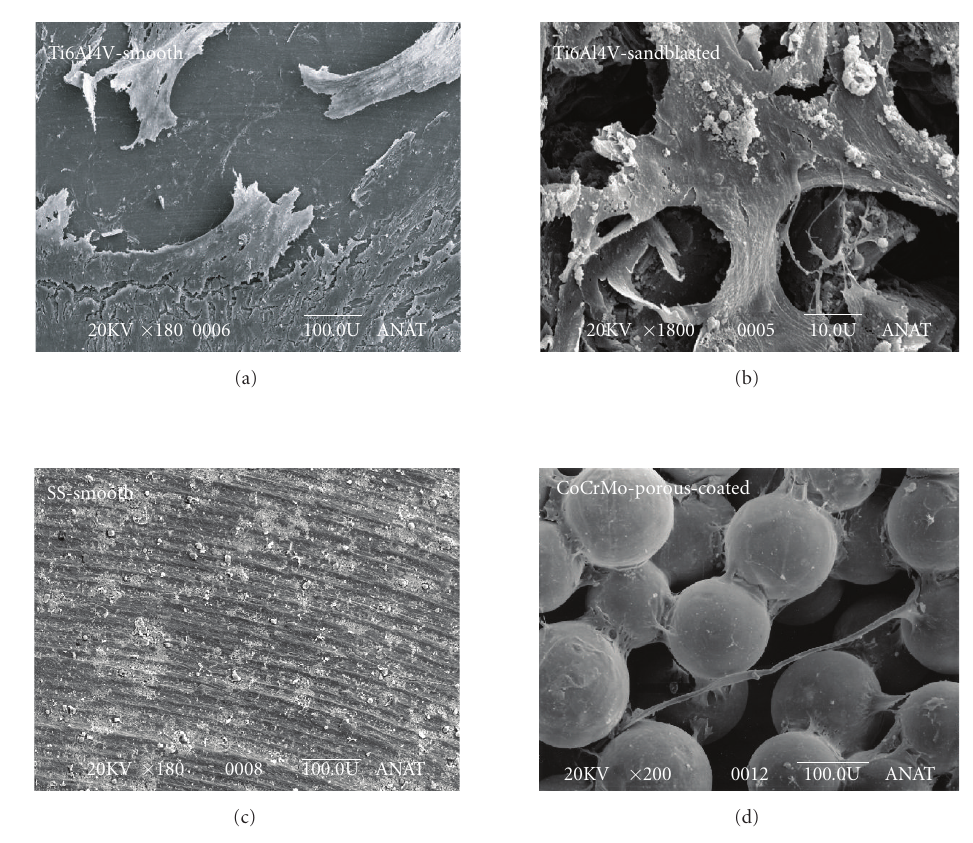
Figure 4: Typical view of human bone marrow cells onto di ff erent surfaces with an endoprosthesis equivalent topography. (a) Polished Ti surface with flat adherent cells after 21 days in vitro. Smooth (polished) surfaces tend to induce a flat cells with a spindle-shape morphology as shown above and also confirmed by other investigators for di ff erent orthopaedic biometals such as Ti, SS, CoCoMo [9, 19, 114–116]. (b) The cells adhered onto a sandblasted Ti surface showed a more inhomogenous star-like morphology. (c) A polished stainless steel (SS) surface showed potential cytotoxic e ff ects on human bone marrow cells which were characterized by a small and round body. (d) A porocoated CoCrMo surface induced various cellular shapes. The high flexibility of the cells is demonstrated by an interconnecting filopode which crosses two metal